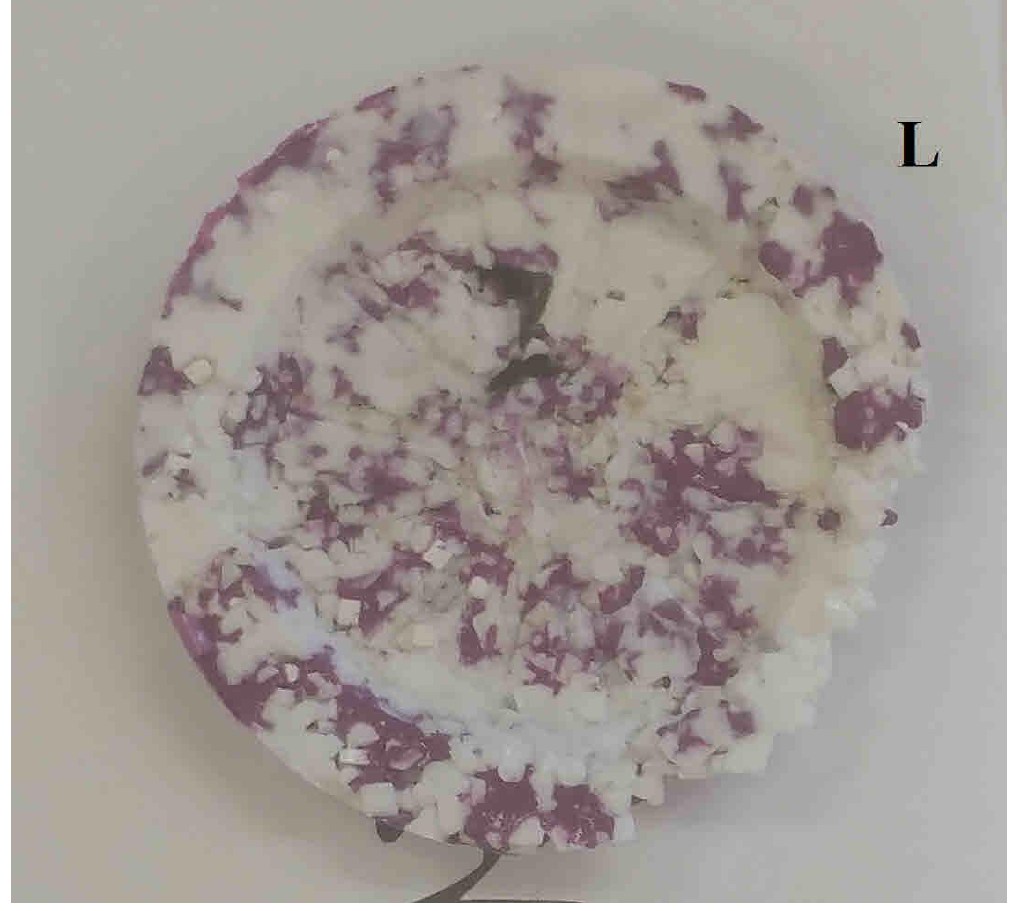
Figure 3. Example compression molding “coaster,” Letter ID = L (see Table 1).